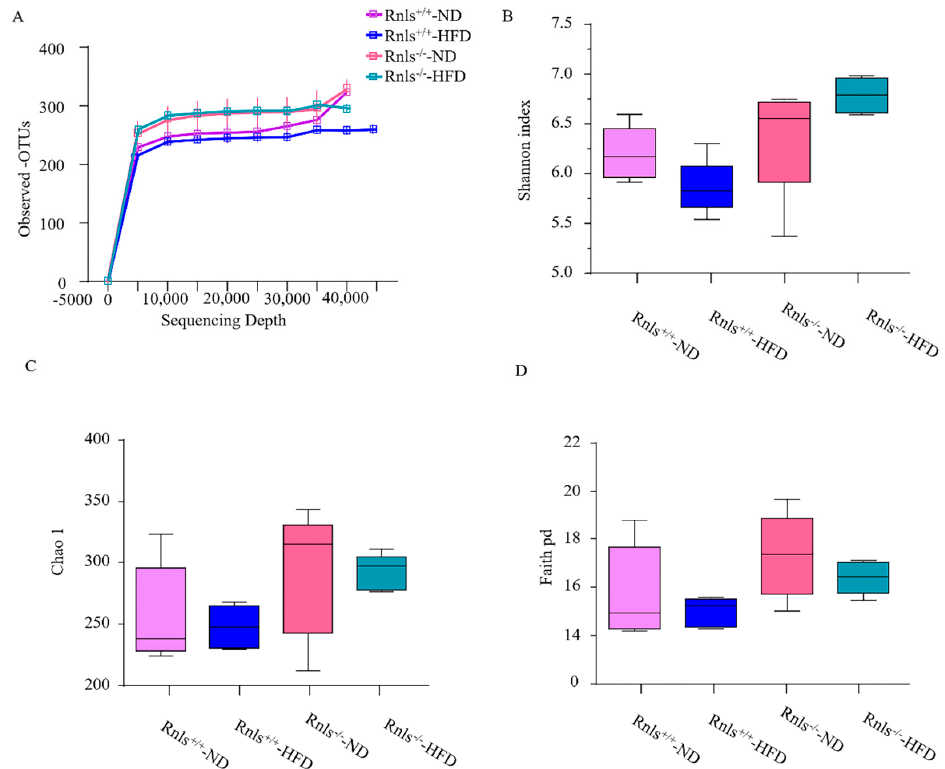
Figure 3. Rarefaction curves showing α -diversity indexes for bacterial communities based on 16S rRNA sequencing. ( A – D ) Intestinal microbial α -diversity in male Rnls –/– and Rnls +/+ mice fed normal diet or high-fat diet. ( A ) Observed Species OTUs, ( B ) Shannon, ( C ) Chao1, and ( D ) Faith-pd. The Emperor α rarefaction was produced based on alpha _diversity.py script in QIIME 2. Rnls –/– -ND, renalase gene knockout mice fed with normal diet; Rnls +/+ -ND, wild-type mice fed with normal diet; Rnls –/– -HFD, renalase gene knockout mice fed with high-fat diet; Rnls +/+ -HFD, wild-type mice fed with high-fat diet; OTUs, operational taxonomic units, Faith-pd, Faith’s phylogenetic diversity.